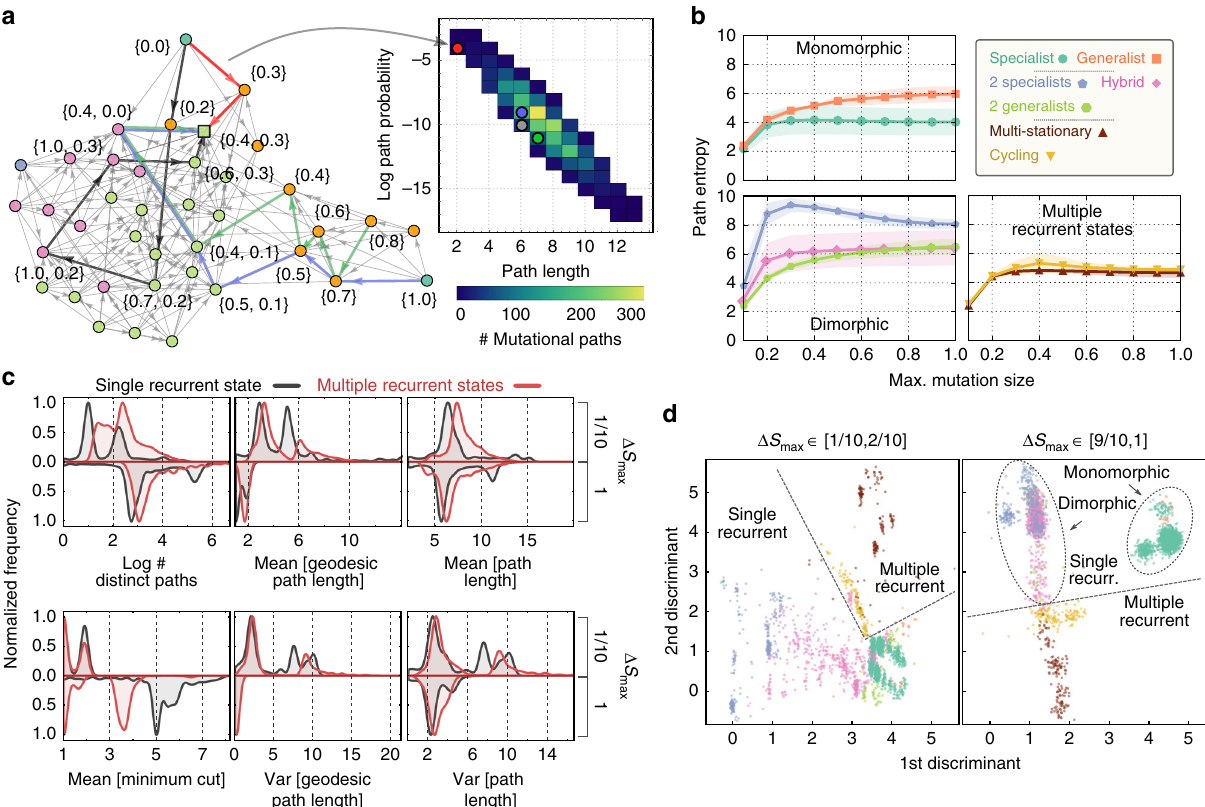
Fig. 5 Different evolutionary outcomes have characteristic adaptation dynamics. Processes with different evolutionary outcomes have characteristic dynamics of adaptation, which can be quanti fi ed and compared through the properties of their mutational paths. a We enumerate mutational paths to generate the distribution of paths. Paths begin at a monomorphic state (with equal probability) and end at a recurrent state. A path ’ s probability is inversely proportional to its length. Most mutational paths are of intermediate length, and only a few are either short or long. b The repeatability of the dynamics of adaptation depends on the long-term evolutionary outcome and does not typically decrease with larger maximum sizes of mutation. The entropy of the distribution of paths quanti fi es repeatability, with high entropy implying low repeatability. Points show the mean path entropy; shaded regions are ± s.d. c Statistics from the mutational paths vary with both the maximum size of mutation and the evolutionary outcome. We plot the distributions for six properties of the paths, grouped by the number of recurrent states and the two extremes of the maximum size of mutation. The distributions are multi- modal, and the peaks correspond to outcomes lower in the classi fi cation of Fig. 3a. d Processes with different evolutionary outcomes have characteristic properties of their mutational paths. Through linear discriminant analysis, we identi fi ed combinations of the six statistics in c that separate the adaptation processes by their evolutionary outcome. A two-dimensional projection of the result is shown with lines and ellipses drawn length of a path as the number of state-to-state transitions in one